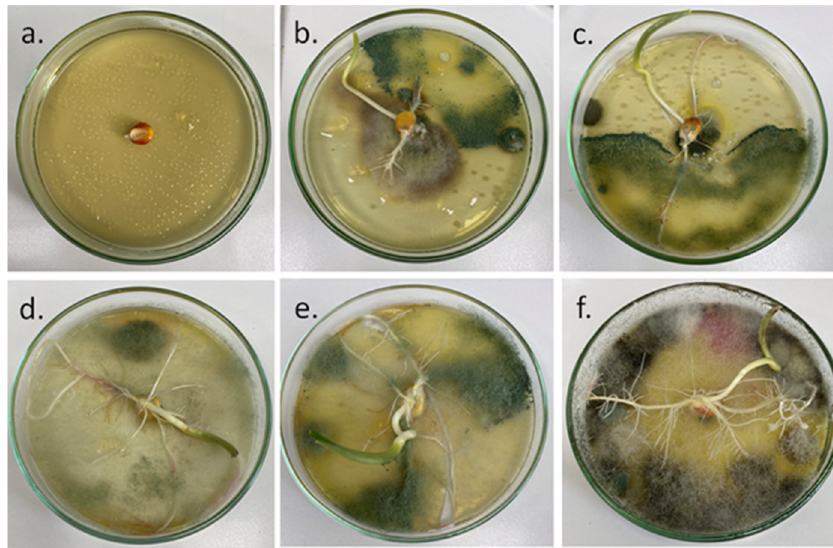
Figure 12. Viability test: corn seed on the first day ( a ), seeds on the 7th day ( b – f ): seeds treated with T. harzianum KUEN 1585 ( b ), G + T ( c ) GC5 + T ( d ), GC10 + T ( e ), GC15 + T ( f ) .